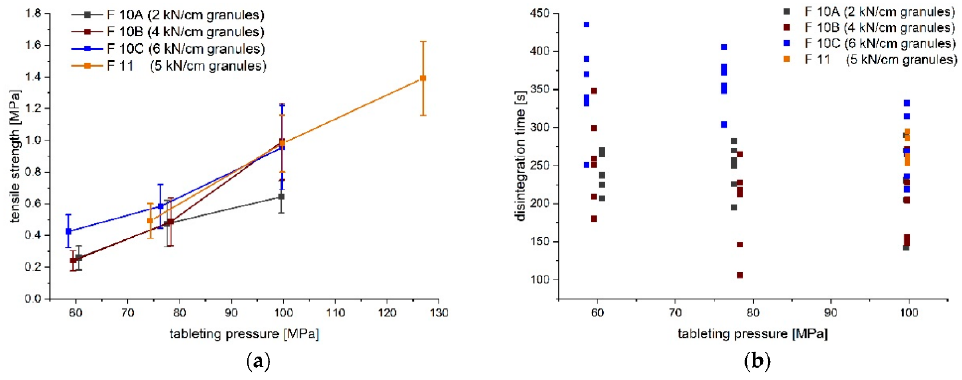
Figure 5. Comparison of ( a ) tabletability (mean ± CI ( α = 0.05), n = 10) and ( b ) disintegration times ( n = 6) of mini-tablets of F 10A, 10B, 10C, and 11.